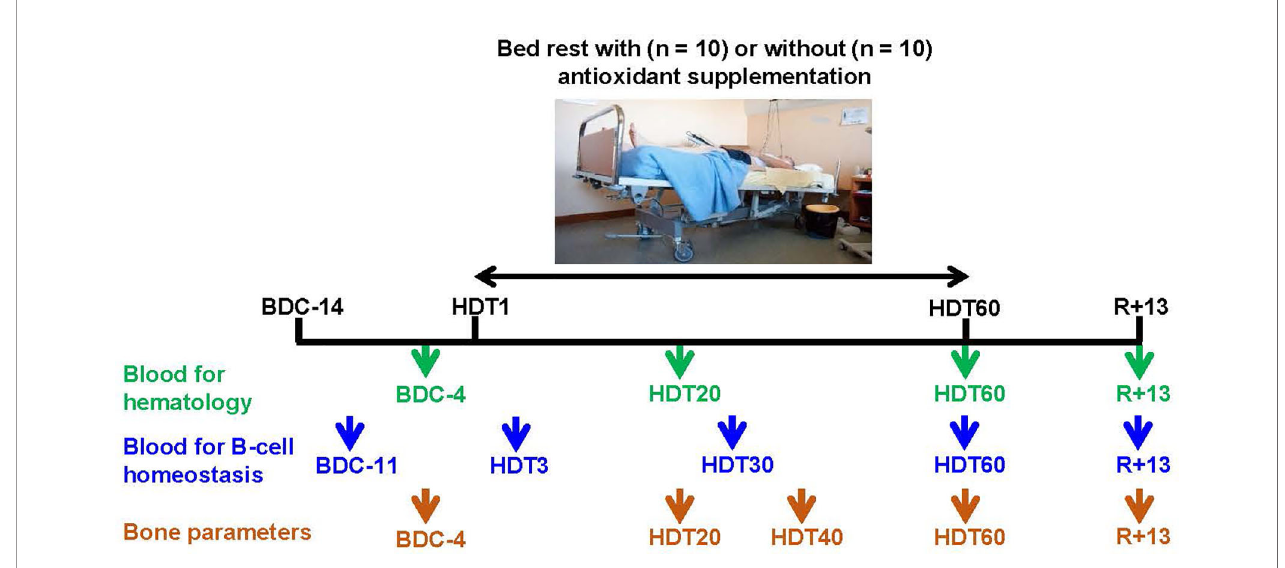
FIGURE 1 | Blood and bone analysis time points. BDC, baseline data collection; HDT, head-down tilt (-6°) bed rest; R, recovery. Trial registered at clinicaltrial.gov as NCT03594799. Photograph copyright, © CNES/Barranco